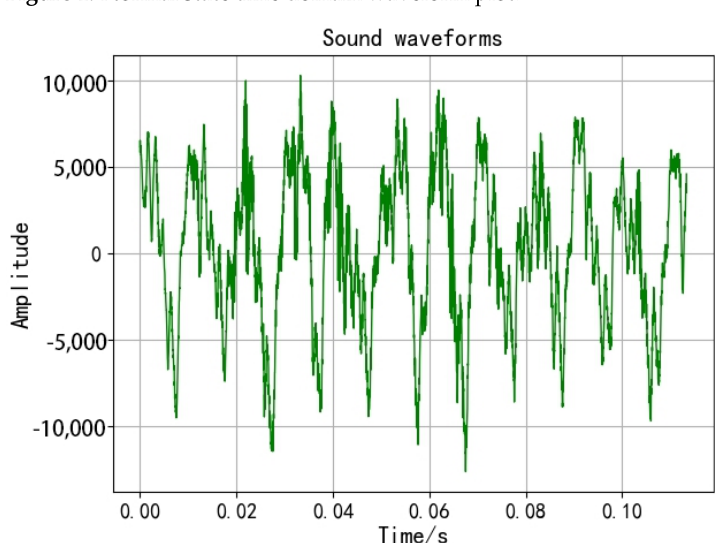
Figure 1. Normal state time domain waveform plot.